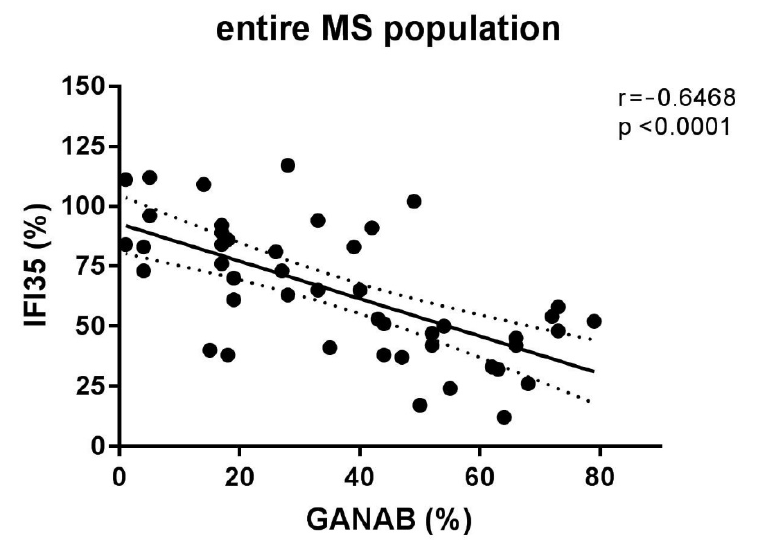
Figure 10. Correlation between the densitometric expression of GANAB and IFI35 in the entire MS population.